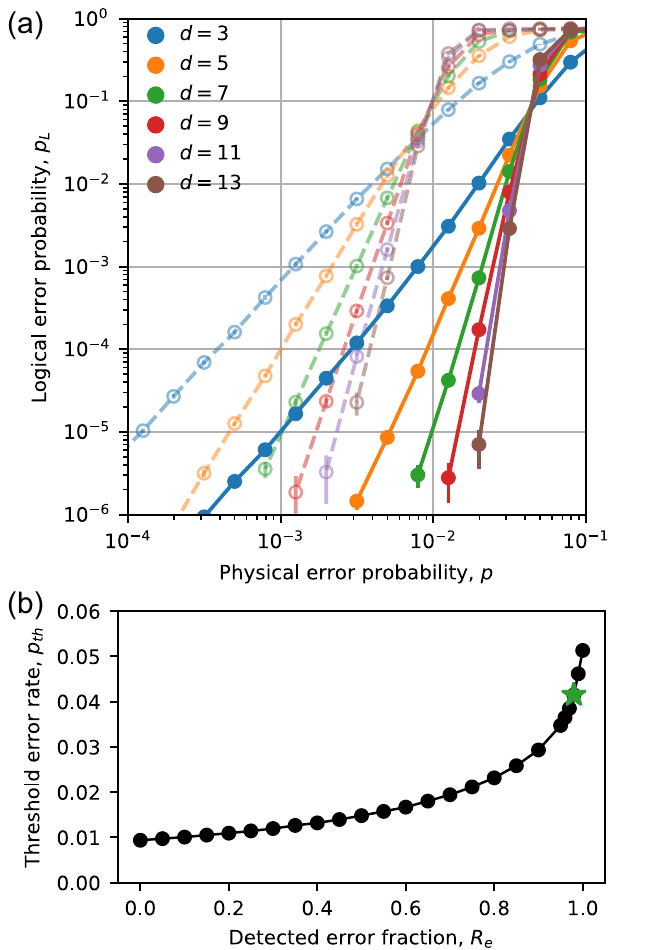
Fig.3|Circuit-levelerrorthresholdsinthepresenceoferasureerrors.a Scaling of the logical error rate with the physical qubit error rate p in the case of pure computational errors ( R e =0, open circles, dashed lines) and in the case of a high conversion to erasure errors, R e =0.98 ( fi lled circles, solid lines). The error thresholdsare p th =0.937(4)%and p th =4.15(2)%,respectively,determinedfromthe crossing of d =11 and d =15. The error bars indicate the 95% con fi dence interval in p L , estimated from the number of trials in the Monte Carlo simulation. b p th as a function of R e (The green star highlights R e =0.98).